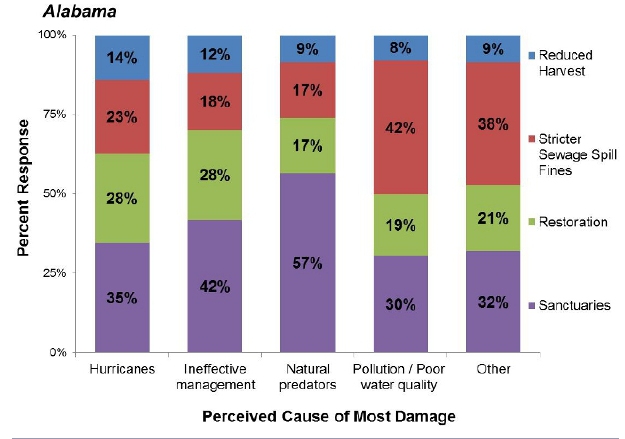
Fig. 3 . Perceived most effective initiative across respondents with differing views on the most damaging stressor for Alabama